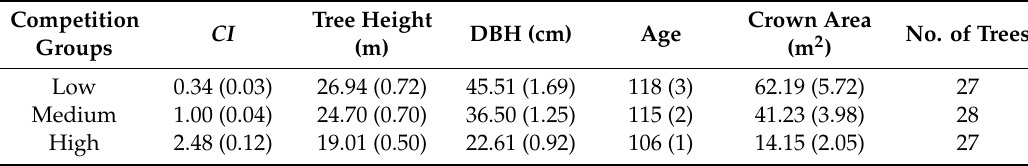
Table 1. Number of trees, average competition index ( CI ), height, diameter at breast height (DBH), age at breast height and crown area for di ff erent competition groups of